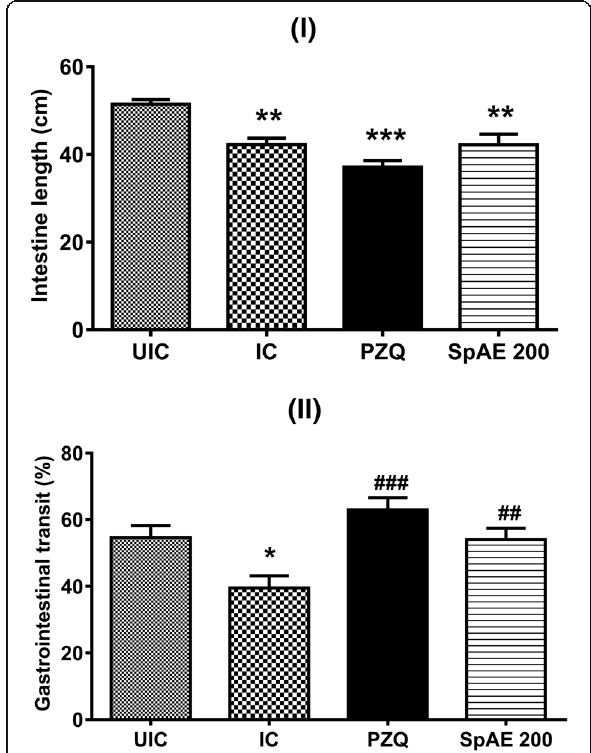
Fig. 4 Effect of oral treatment of Sida pilosa aqueous extract on the intestine length ( I ) and gastrointestinal transit ( II ) of Schistosoma mansoni - infected mice. UIC: uninfected-untreated mice; IC: infected-untreated mice; PZQ: infected mice treated with praziquantel; SpAE 200: infected mice treated with Sida pilosa aqueous extract at 200 mg/kg. Data are expressed as mean±SEM ( n =6). ANOVA followed by Newman-Keuls multiple comparison test was used for statistical analysis. * p <0.05, ** p <0.01, *** p <0.001: values are significantly different from those of uninfected- untreated mice (group UIC). ## p <0.01, ### p <0.001: values are significantly different from those of infected-untreated mice (group